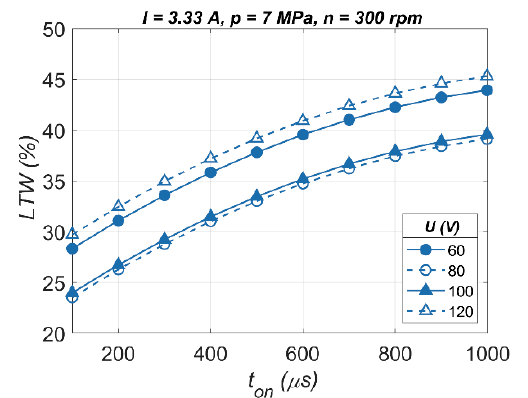
Figure 8. The impact of various values of the open voltage on the linear tool wear LTW .